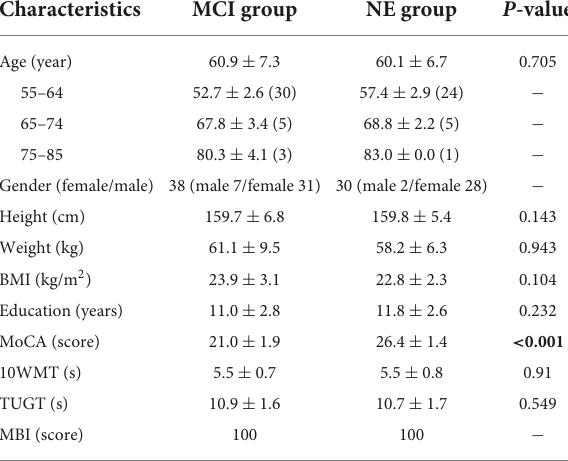
TABLE 1 Baseline demographic characteristics of the MCI group and NE group.